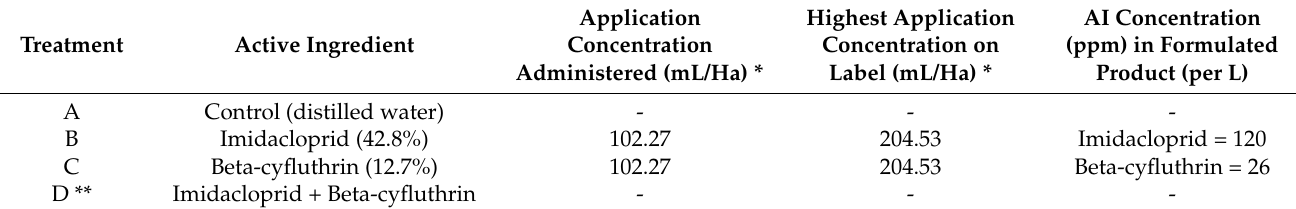
Table 4. Application concentrations administered, highest recommended application concentrations, and active ingredient concentrations of individual active ingredient insecticides assessed for acute whole-body contact toxicity to adult male and female Osmia lignaria (Experiment